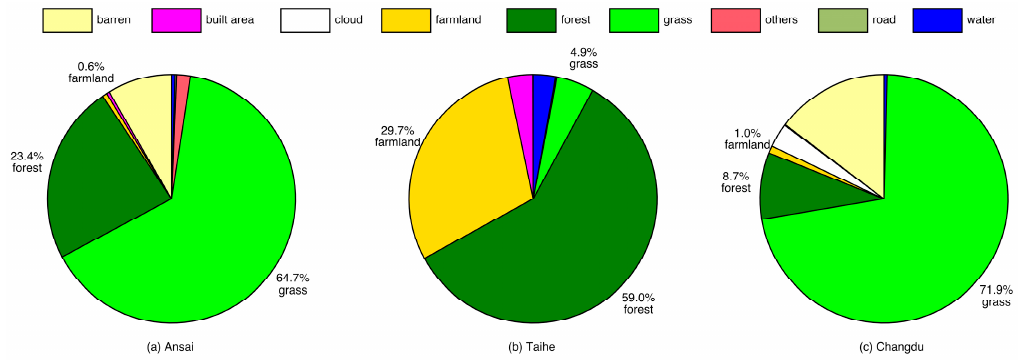
Figure 13. Proportion of the area of the ground features in: ( a ) Ansai; ( b ) Taihe; and ( c ) Changdu. Forest is the primary ground feature in Taihe County, accounting for up to 59.0%. Grassland